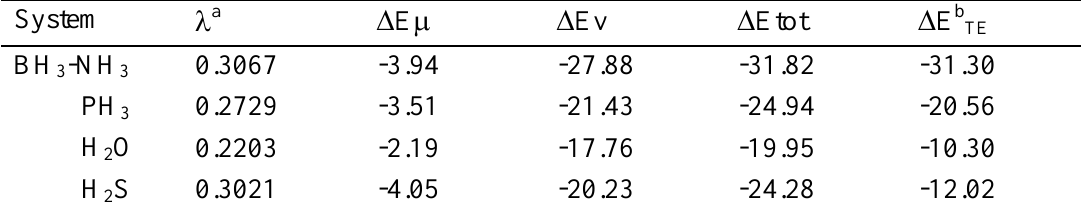
Table 4 : The interaction energies for the Lewis acid-base complexes (Energies in kcal/mol) System